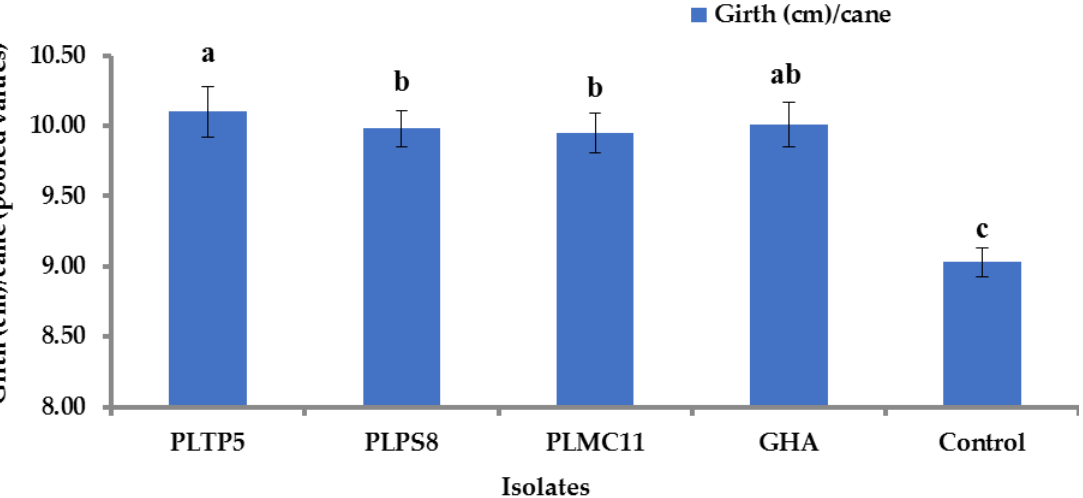
Figure 12. Effect of EPF conidia formulation application on the girth of sugarcane. Different letters (a–c) in columns indicate significant differences ( p ≤ 0.05) among the isolates. Columns represent the mean ± SD ( n = 3). SD = standard deviation.